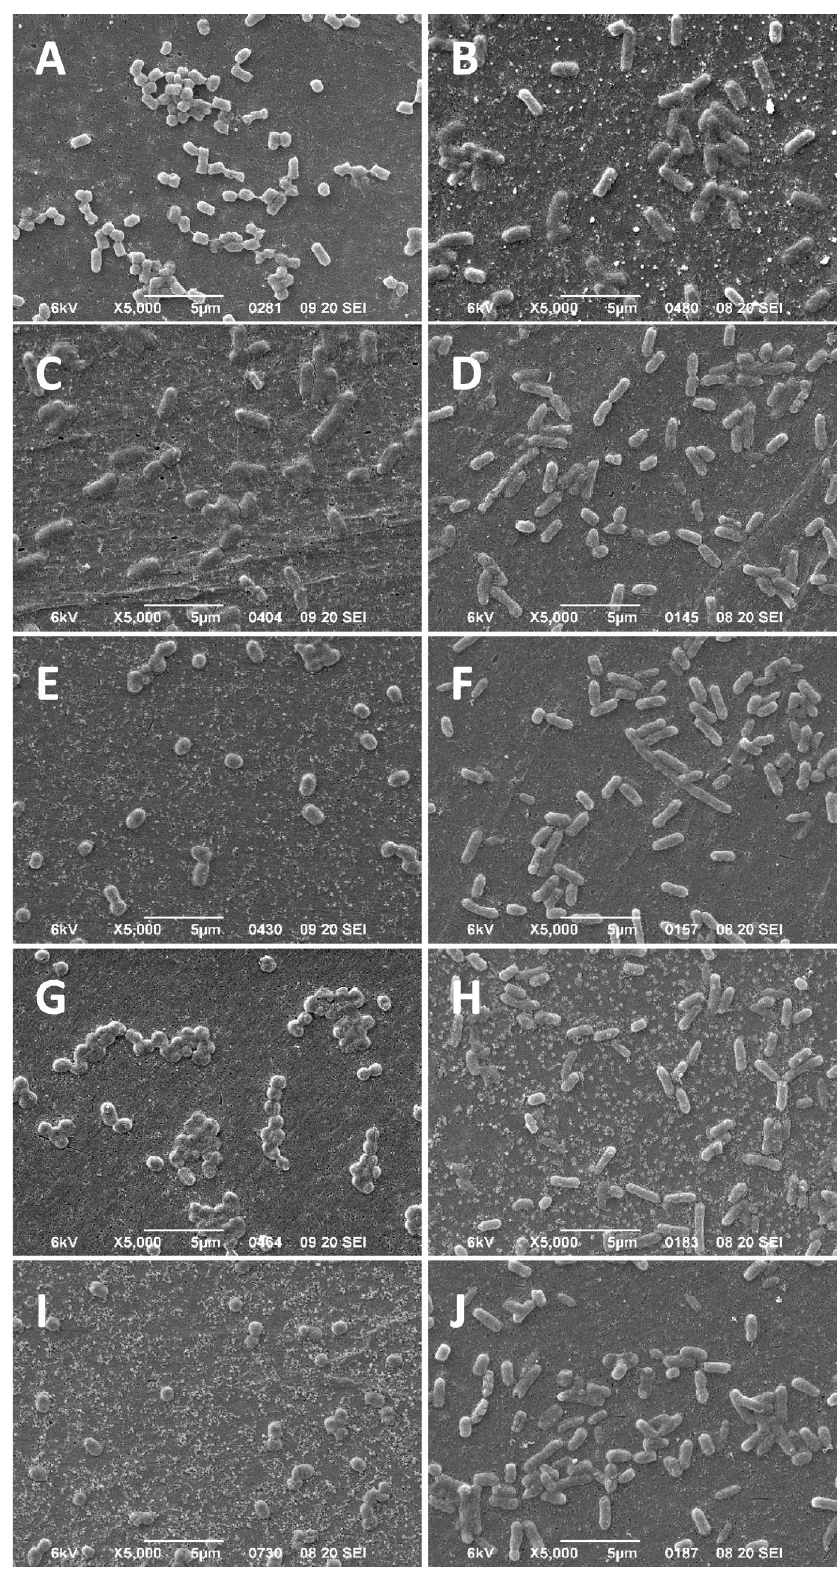
Figure 3. SEM images of EC and ECBZKT exposed to increasing concentrations of BZK for 30-min. ( A , C , E , G , I ) show EC isolates and ( B , D , F , H , J ) show ECBZKT isolates after 30-min exposure to BZK at 0 µg/mL ( A , B ), 9.4 µg/mL ( C , D ), 18.8 µg/mL ( E , F ), 75 µg/mL ( G , H ) and 150 µg/mL ( I , J ). All images are representative of five SEM images collected at 5000× magnifications and the white scale bar at the bottom of each panel image indicates 5 µm